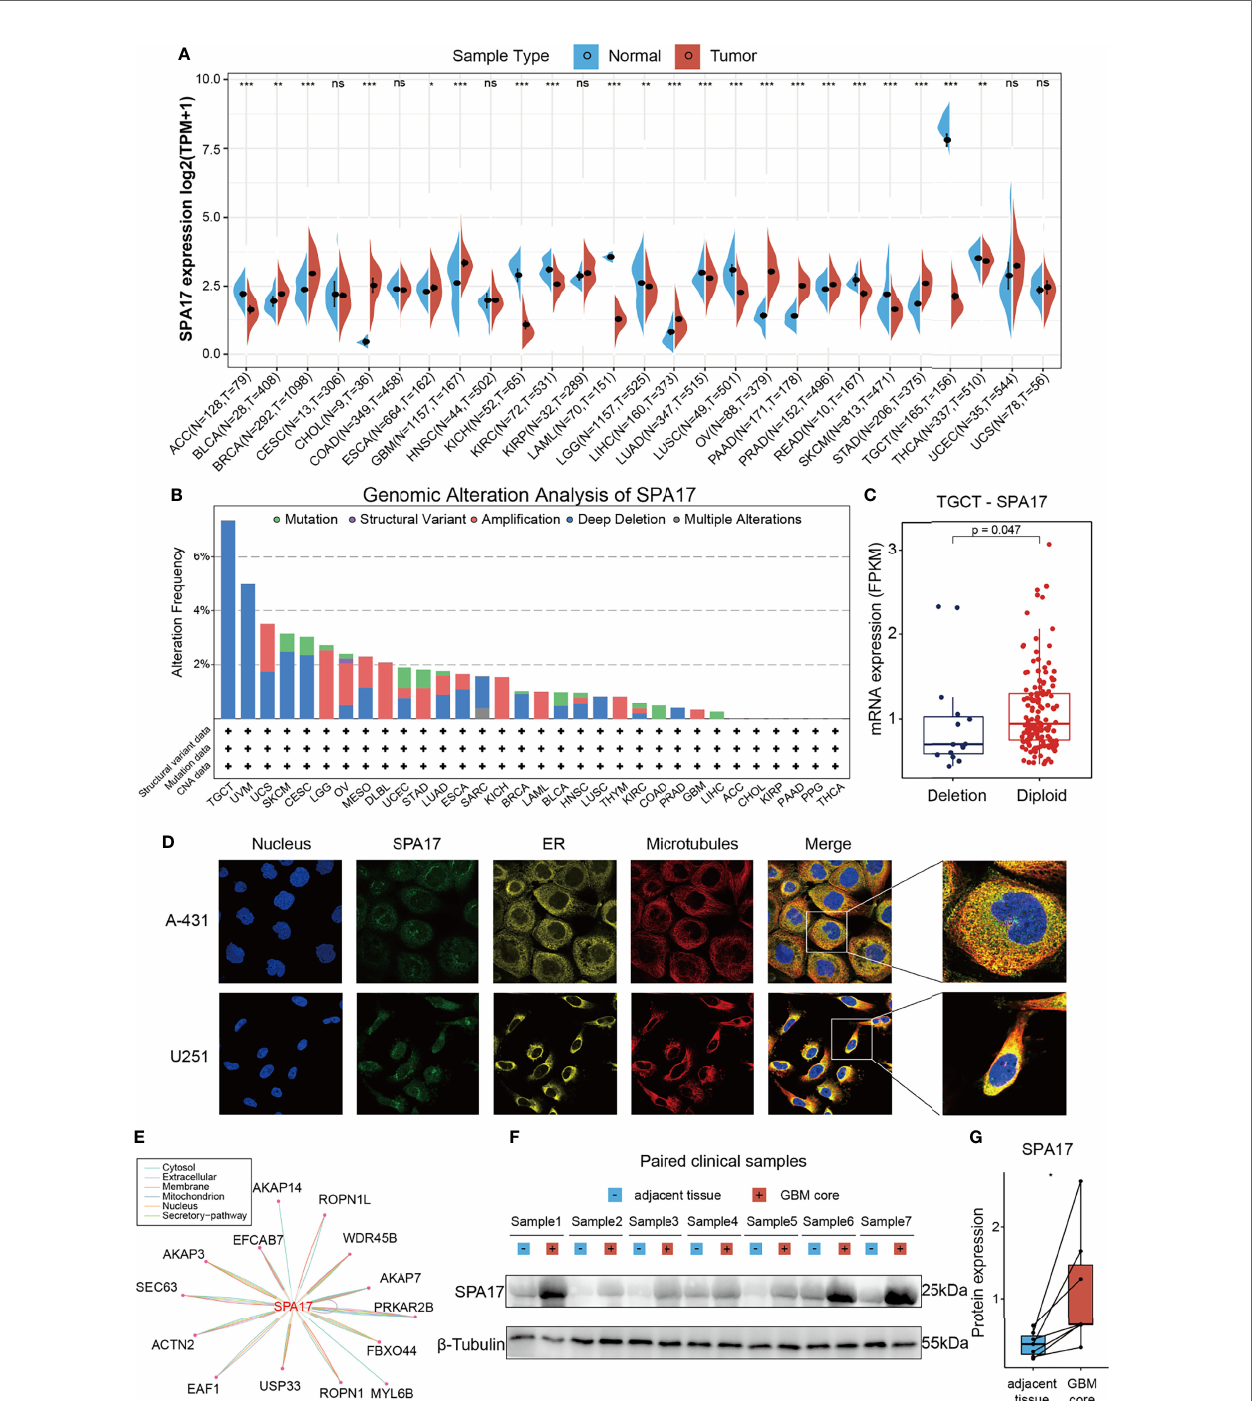
FIGURE 1 | Basic information of SPA17. (A) The level of SPA17 expression between tumor and normal tissues in each type of cancer based on the integrated data from TCGA and GTEx datasets. (B) Analysis of SPA17 change frequency in pan-cancer research according to cBioPortal database. (C) The SPA17 expression levels between SPA17-deletion and diploid TGCT patients. (D) The immuno fl uorescence images of SPA17 protein, nucleus, endoplasmic reticulum (ER), microtubules and the incorporative images in A-431 and U251 cell lines. (E) The protein-protein interaction (PPI) network presents the proteins interacting with SPA17. (F, G) Western blot protein detection of the SPA17 expression levels in paired GBM and adjacent normal tissues. The labelled asterisk indicated the statistical p-value (ns, p > 0.05, *p < 0.05, **p < 0.01 and ***p <